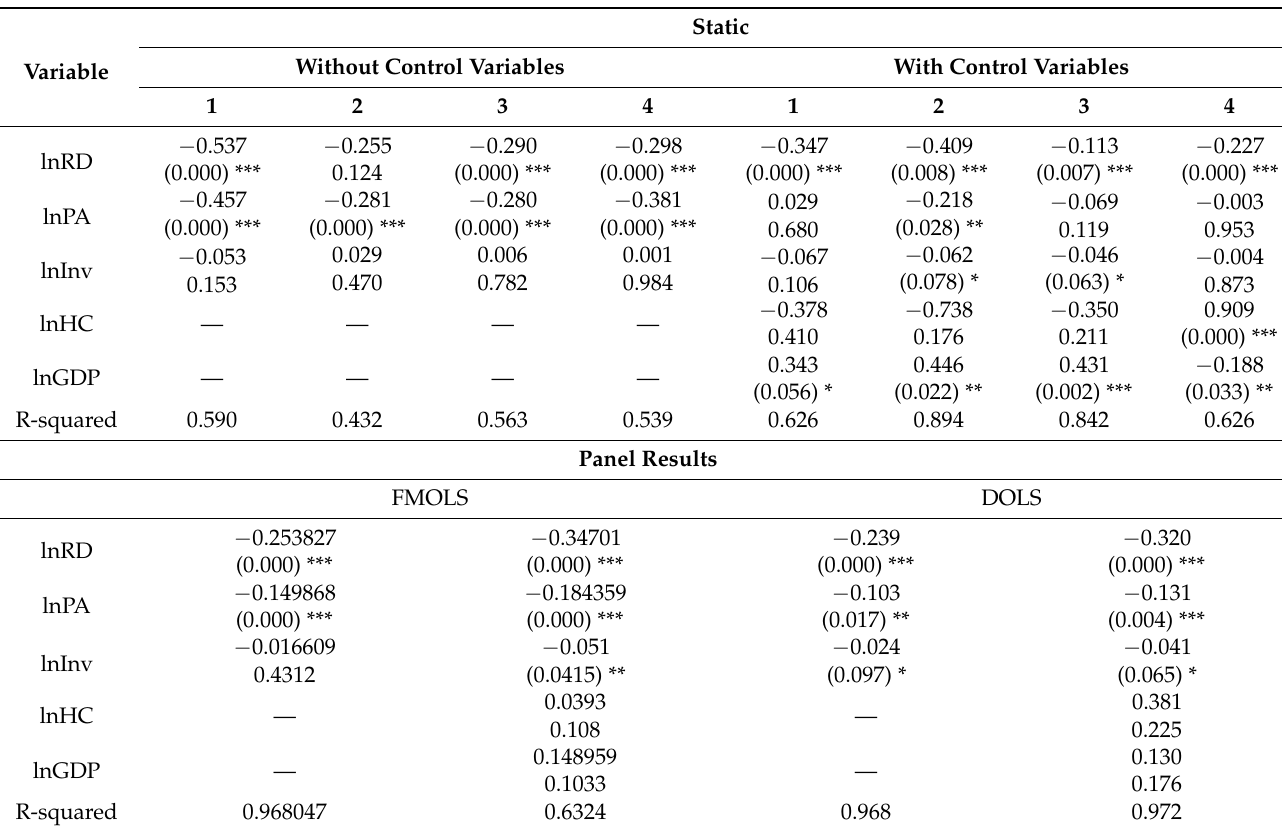
Table 5. Results of analysing the impact of the selected variables on GHG emissions (Source: developed by the author).